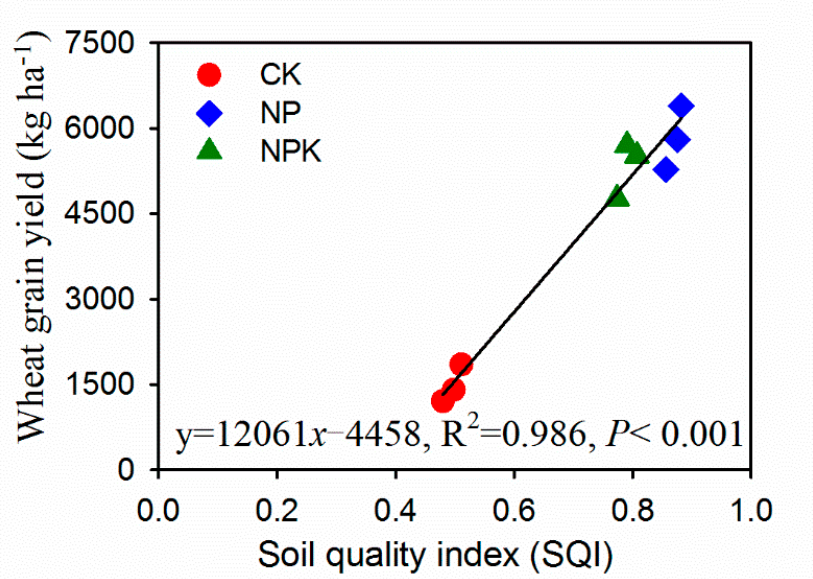
Figure 7. Linear relationship between soil quality index (SQI) and wheat grain yield (kg ha –1 ) across different long-term fertilizer treatments (CK—no fertilizer; NP—nitrogen and phosphorous fertilizer; NPK—nitrogen, phosphorus, and potassium fertilizer). The relationship is described by the regression equation y = 12061 x − 4458; R 2 = 0.986; p < 0.001. R 2 is the coefficient of determination.